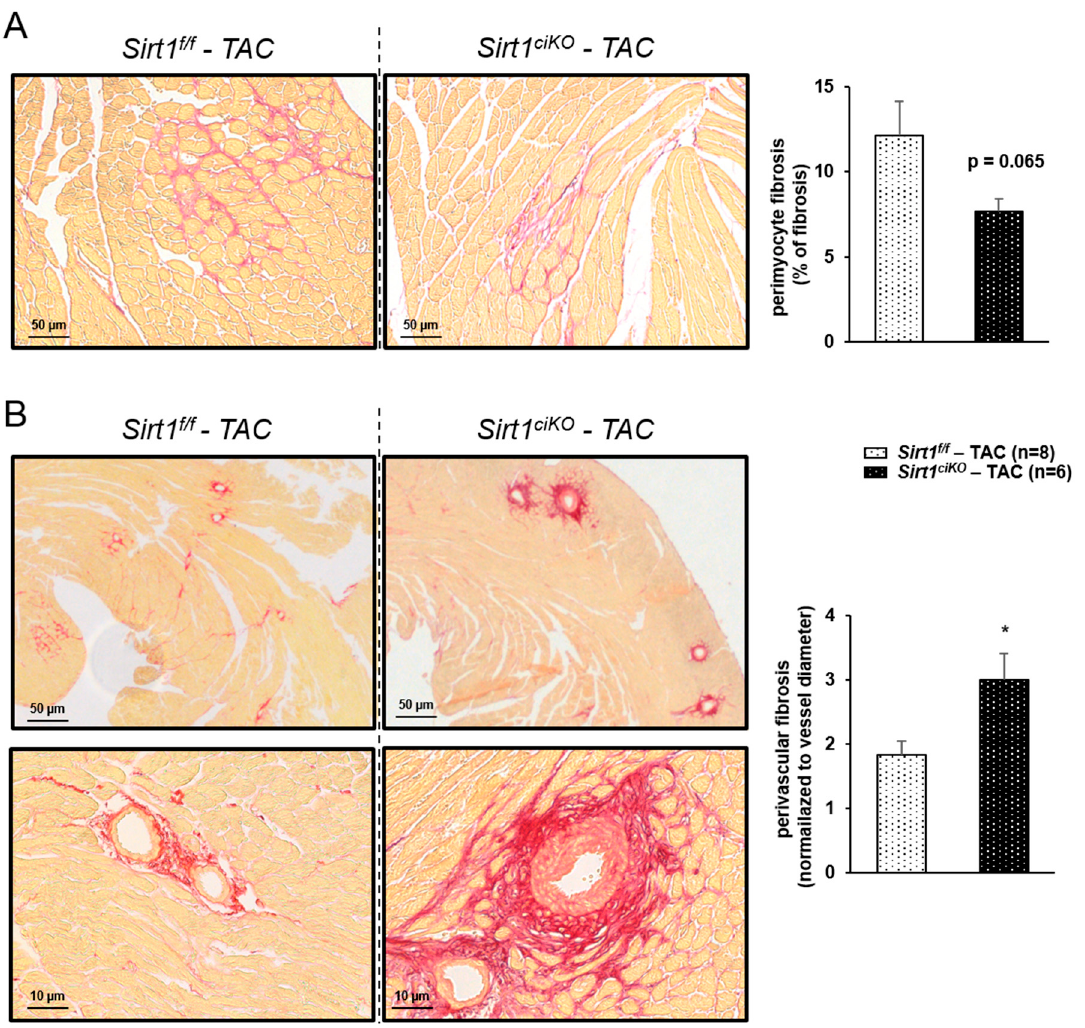
Figure 7. Myocardial fibrosis after 8 weeks of pressure overload. ( A ) Perimyocyte fibrosis analysis by Sirius red staining of subequatorial heart sections. ( B ) Perivascular fibrosis analysis by Sirius red staining of subequatorial heart sections. ( n = 6 to 8 per experimental group), * p < 0.05 Sirt1 f / -TAC f versus Sirt1 ciKO -TAC.